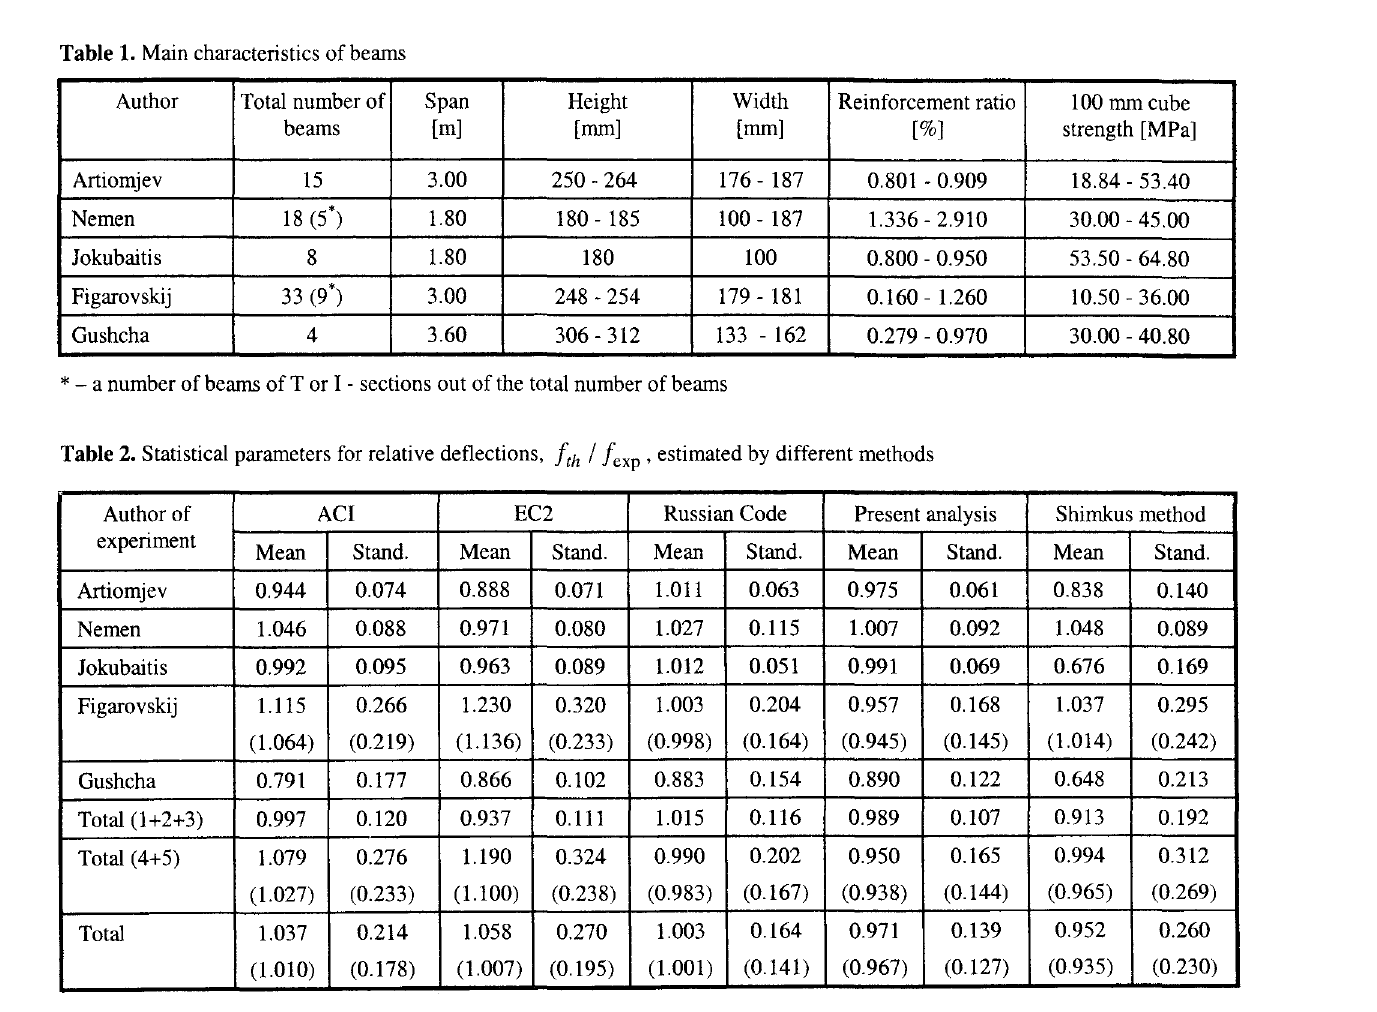
Table 1. Main characteristics of beams Author